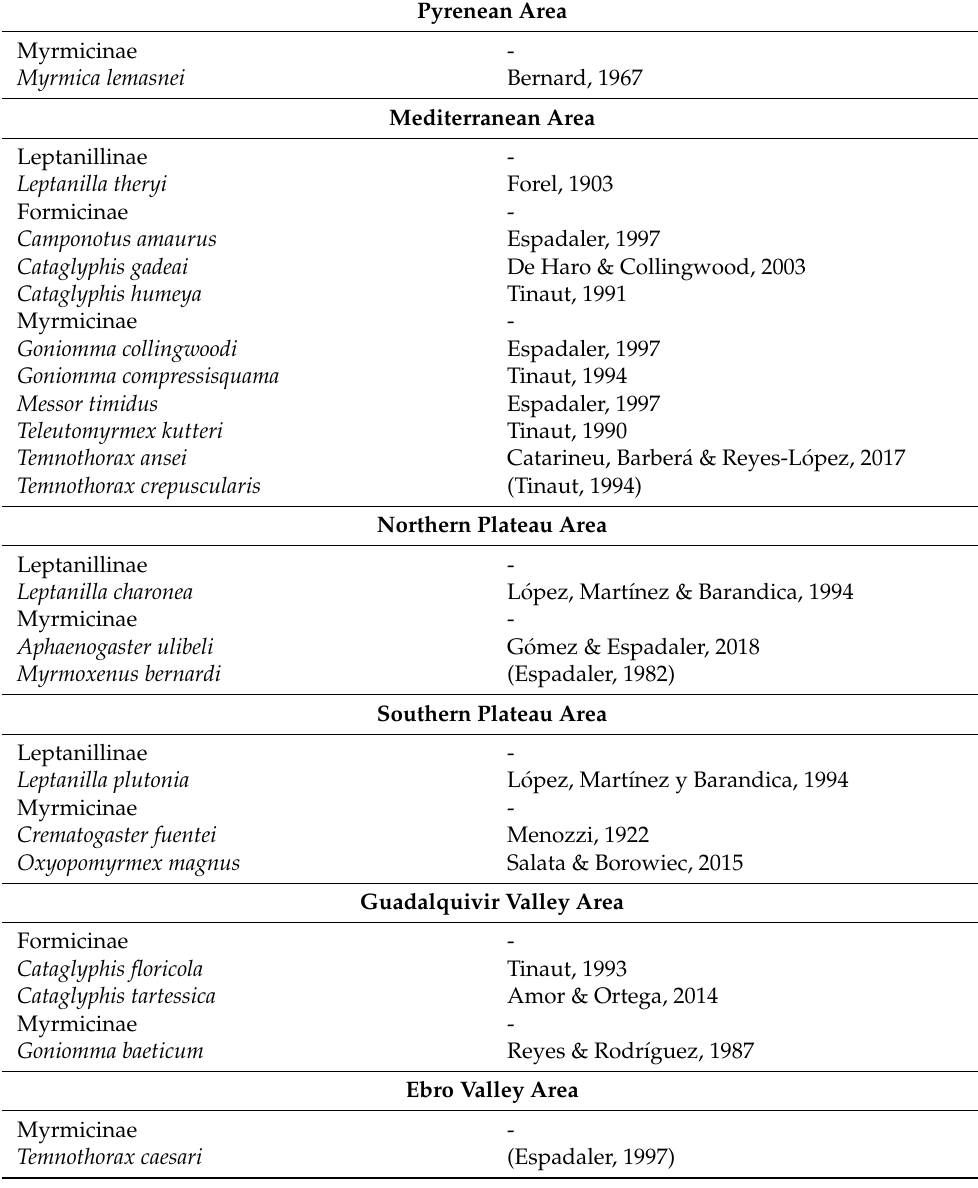
Table 5. List of 21 endemic species appearing in only one refugium area in the